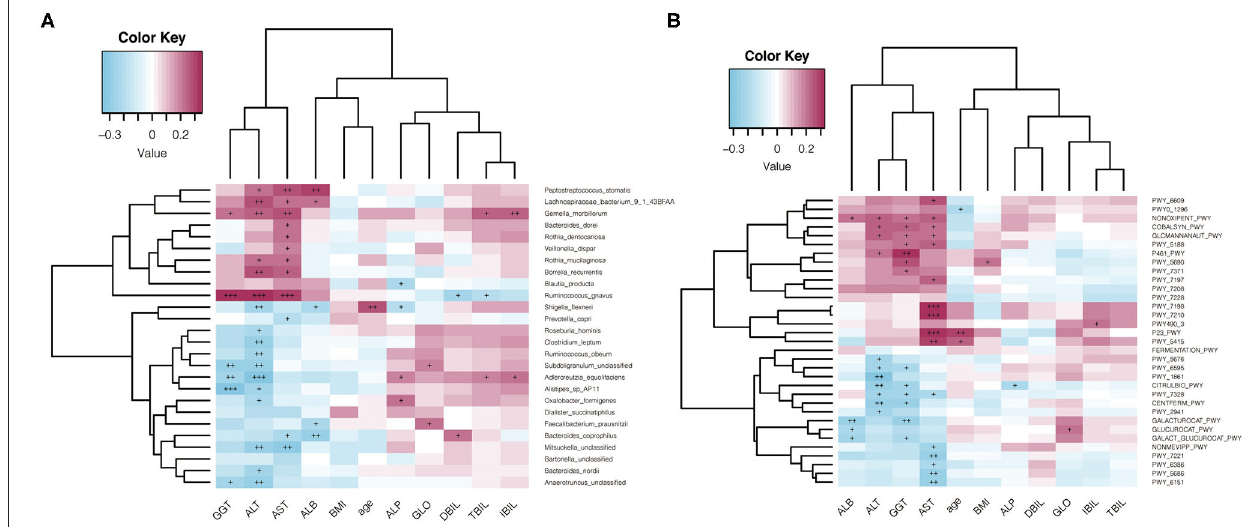
FIGURE 6 | Spearman correlation analysis. (A) Spearman analysis of species abundance and clinical indexes; (B) Spearman analysis of metabolic pathways and clinical